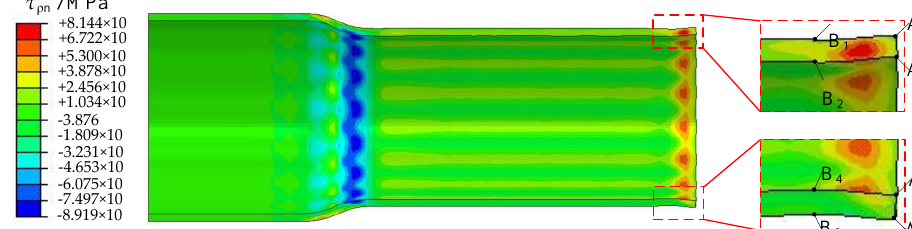
Figure 21. Warping stage. Figure 21. Warping